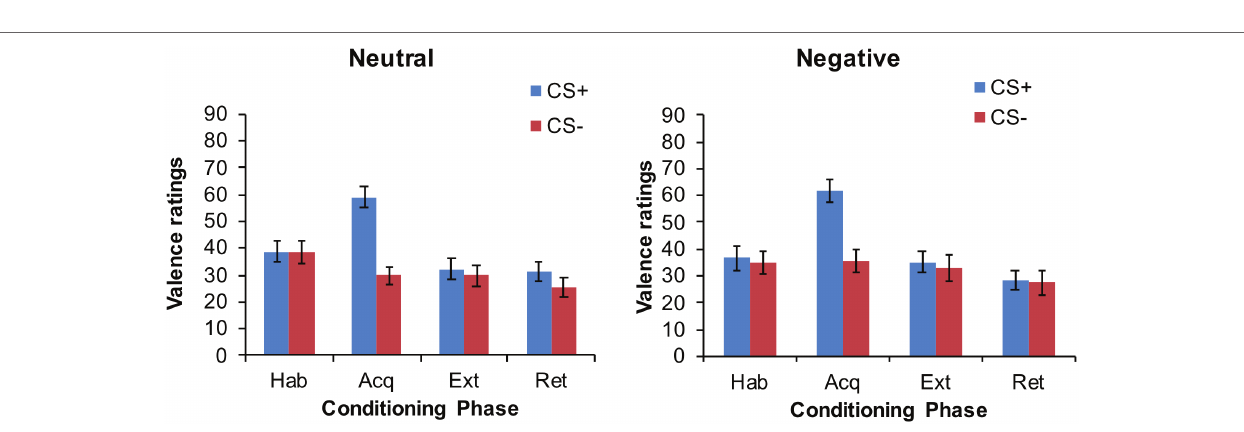
FIGURE 3 | Mean CS valence ratings at the end of each conditioning phase in the neutral and negative